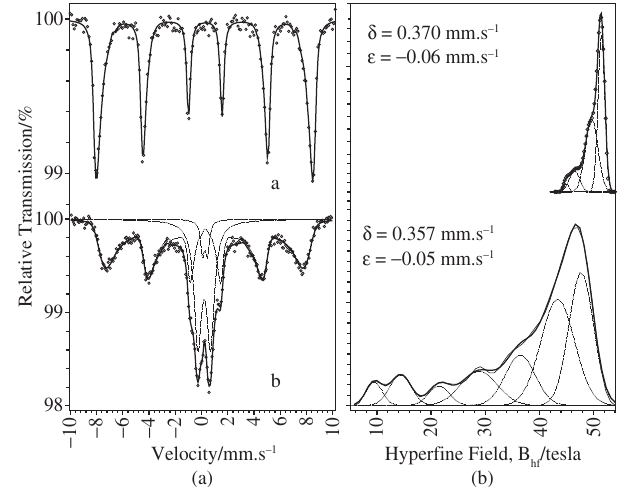
Mn Mo O perovskite pure 0.90 0.08 0.02 3 O (left side) and hyperfine field 2 3